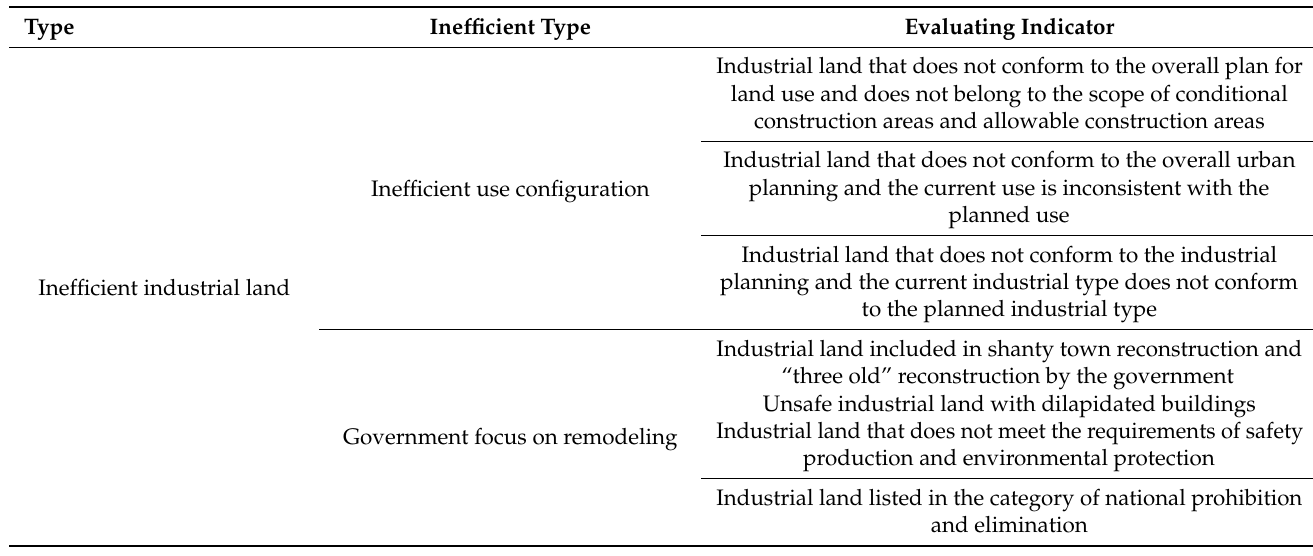
Table 3. Identification standards of inefficient industrial land.